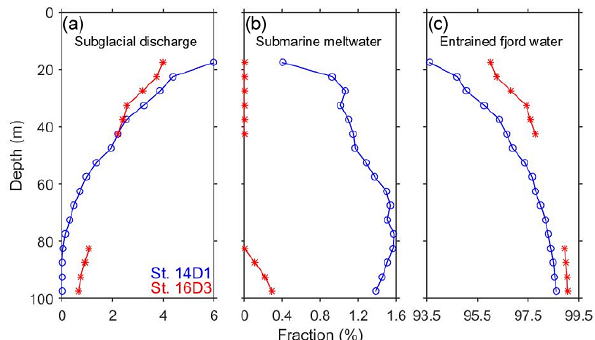
Figure 8. Vertical profiles of the three water mass fractions of (a) subglacial discharge, (b) submarine meltwater, and (c) entrained fjord water at stations 14D1 (blue) and 16D3